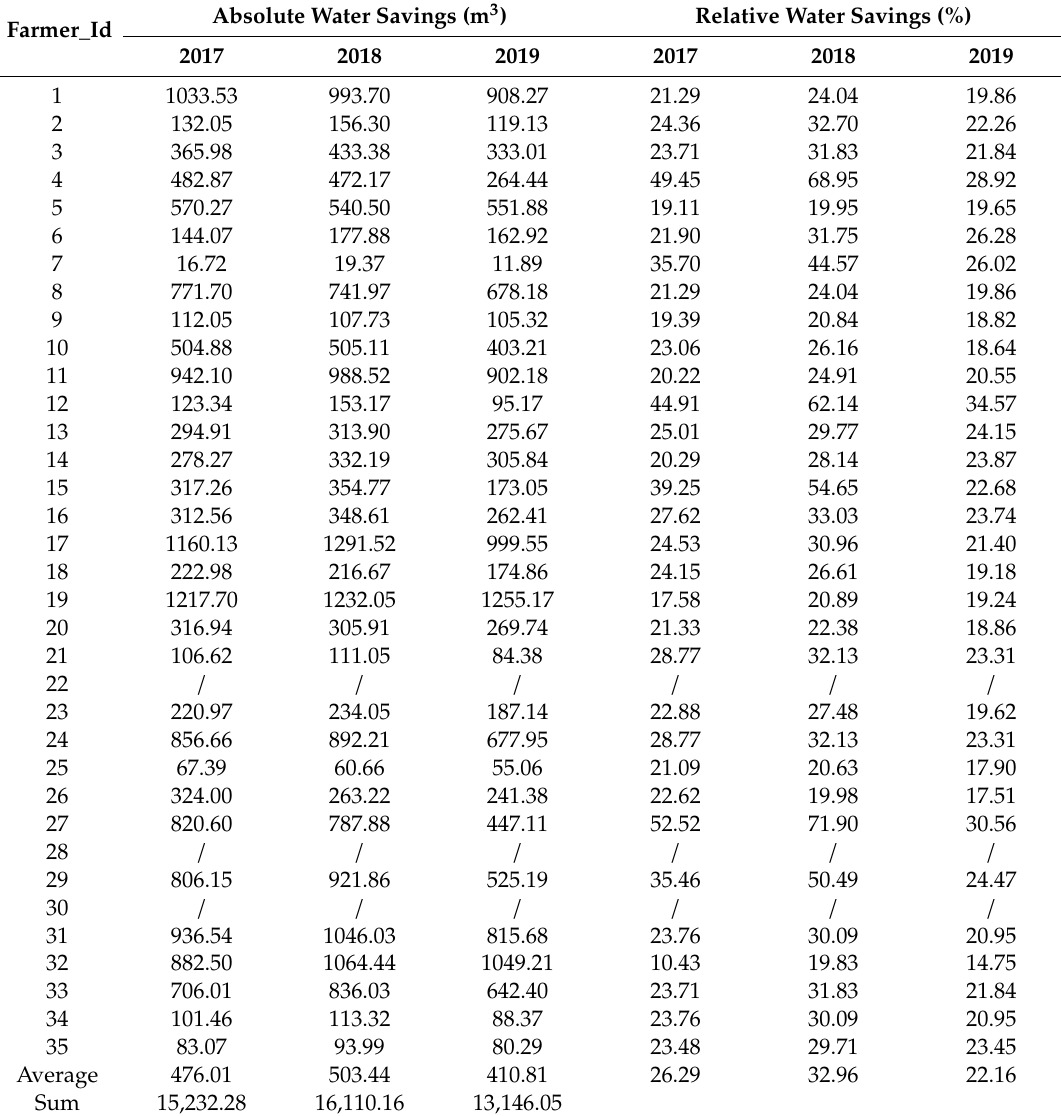
Table A8. Yearly absolute (m 3 ) and relative (%) water savings at farm level if replenishing soil water content to 85% capacity (FC-WP) instead to